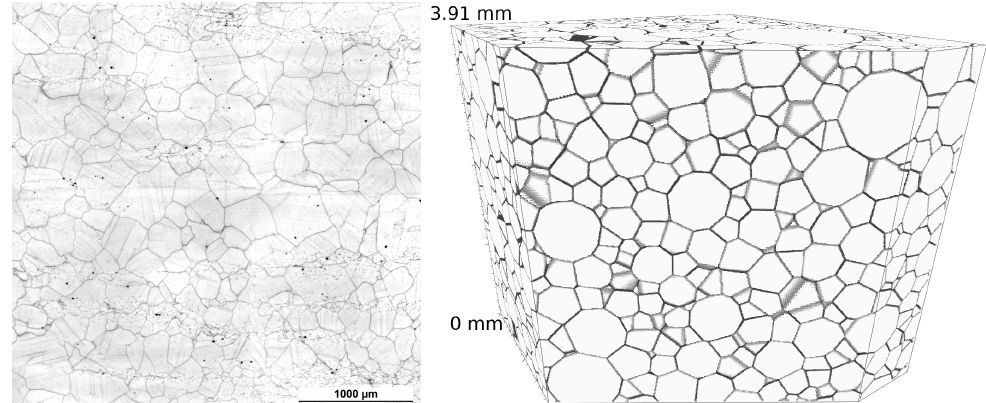
Figure 10. One of the original micrographs of the Inconel-617 and a rendering of a realization of the fitted Laguerre tessellation model with cv s = 3.5 and 2000 cells.